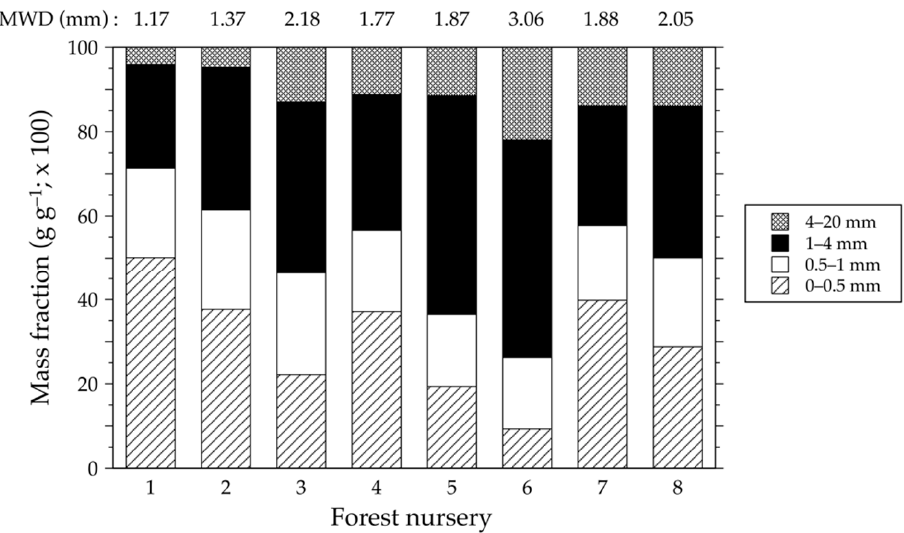
Figure 3. Mean weight diameter (MWD; above each stack column) and the proportion of peat particles with a diameter < 0.5 mm and between 0.5 and 1 mm, 1 and 4 mm and 4 and 20 mm in nursery substrates after